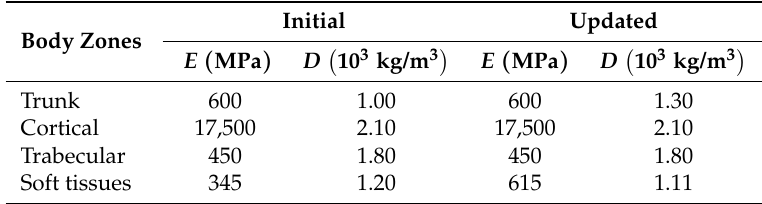
Table 3. Initial and updated mechanical properties. E : Young modulus, D :